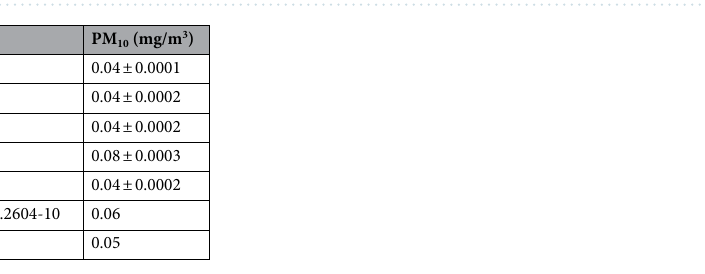
Table 4. Comparison of PM 10 particles concentrations with air quality